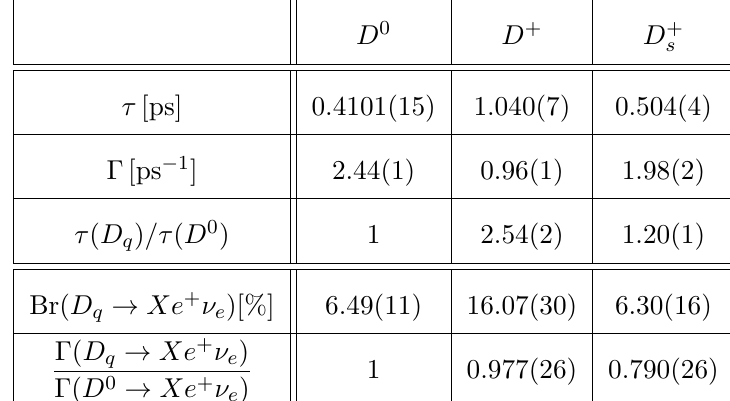
Table 1 . Status of the experimental determinations of the lifetime and the semileptonic branching fractions of the lightest charmed mesons ( D